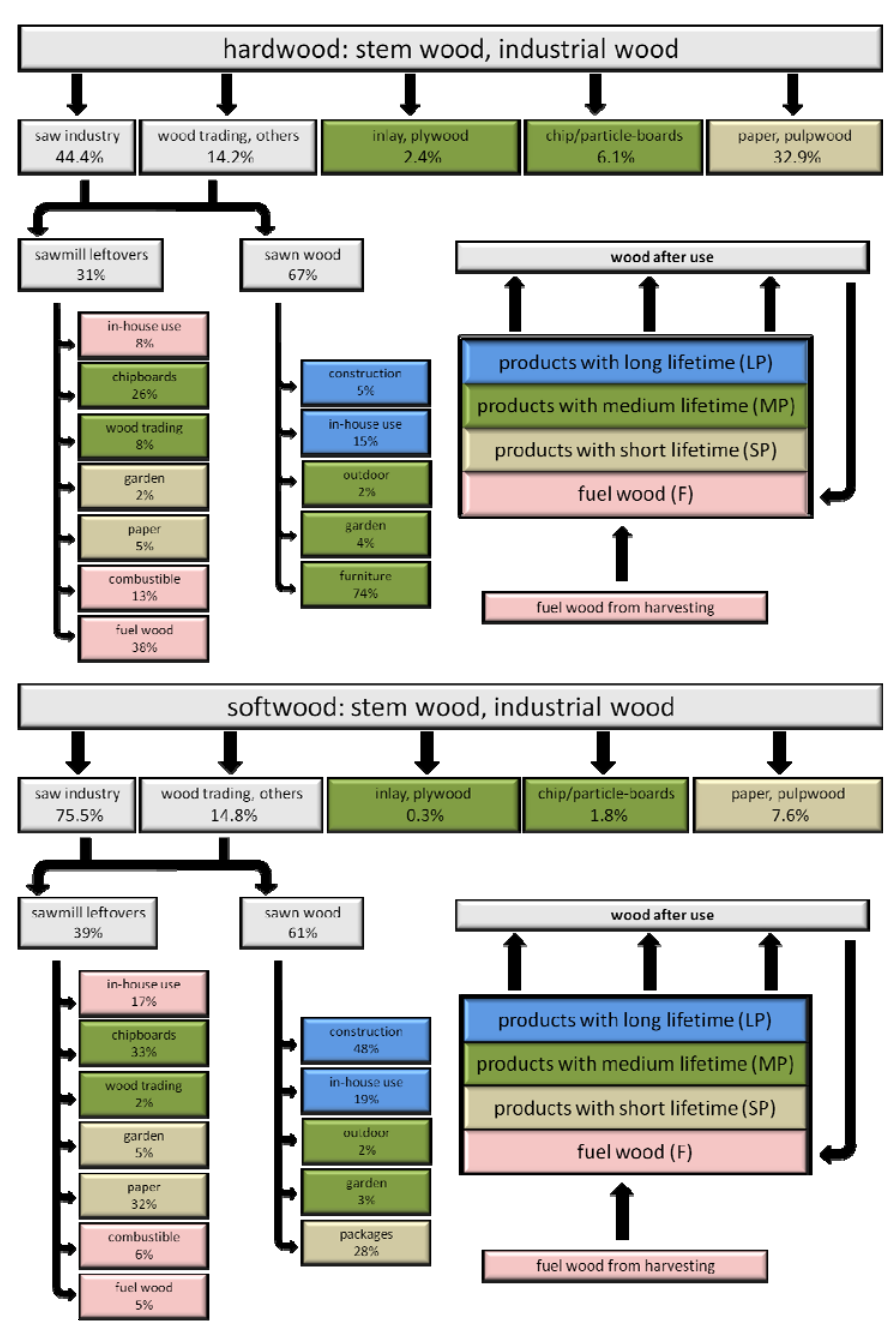
Figure 2. Wood material flow for softwood and hardwood (stem and industrial wood) in Bavaria in 2006 (figure derived from data of